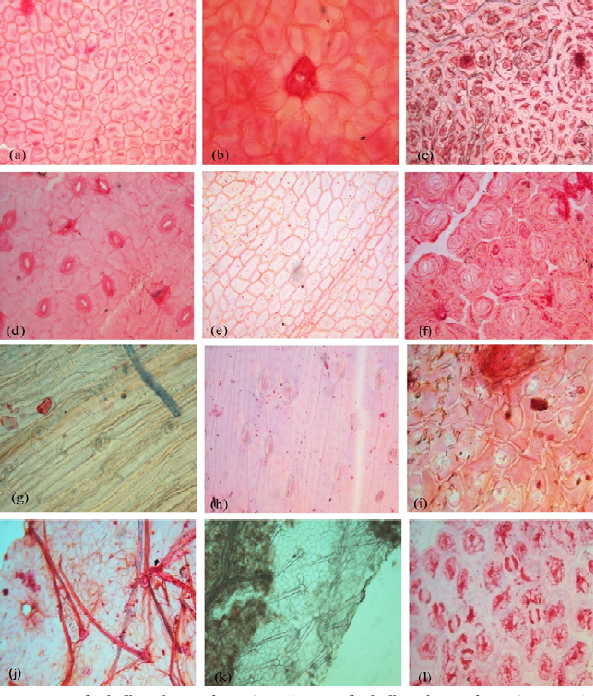
Fig. 3. a. Podophyllum hexandrum (Cells); b. Podophyllum hexandrum (Stomata); c. Rheum spiciforme ; d. Exacum tetragonum ; e. Dactylorhiza hatagirea ; f. Convolvulus arvensis ; g. Colchicum luteum ; h. Allium carolinianum; i. Draba gracillima ; j. Oxytropis lapponica ; k. Geranium pratense ; l. Anemone replica (Cells)